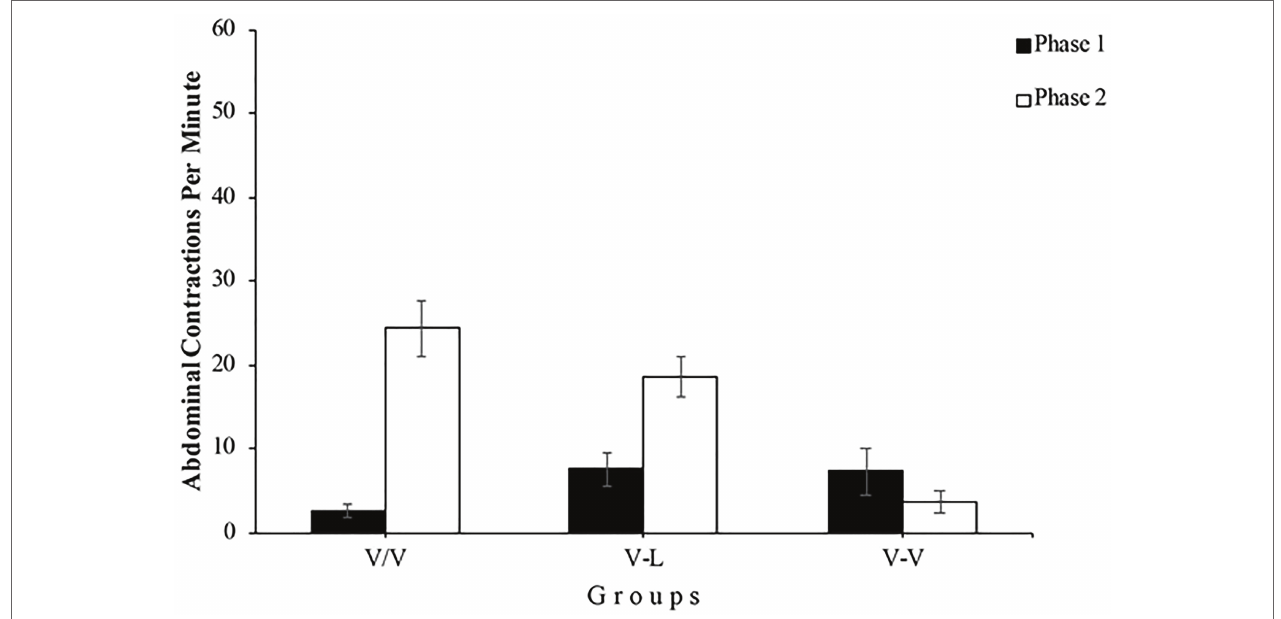
FIGURE 5 | Mean abdominal contractions during the last minute of Phase 1 (black bars) and the first minute of Phase 2 (white bars) of Experiment 2. Error bars denote standard errors of the